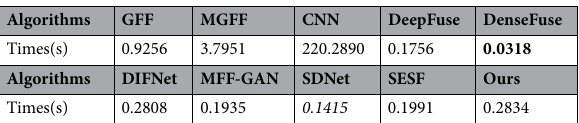
Table 2. Comparison of fusion time of various algorithms. Bold is the best, italic is the second best.